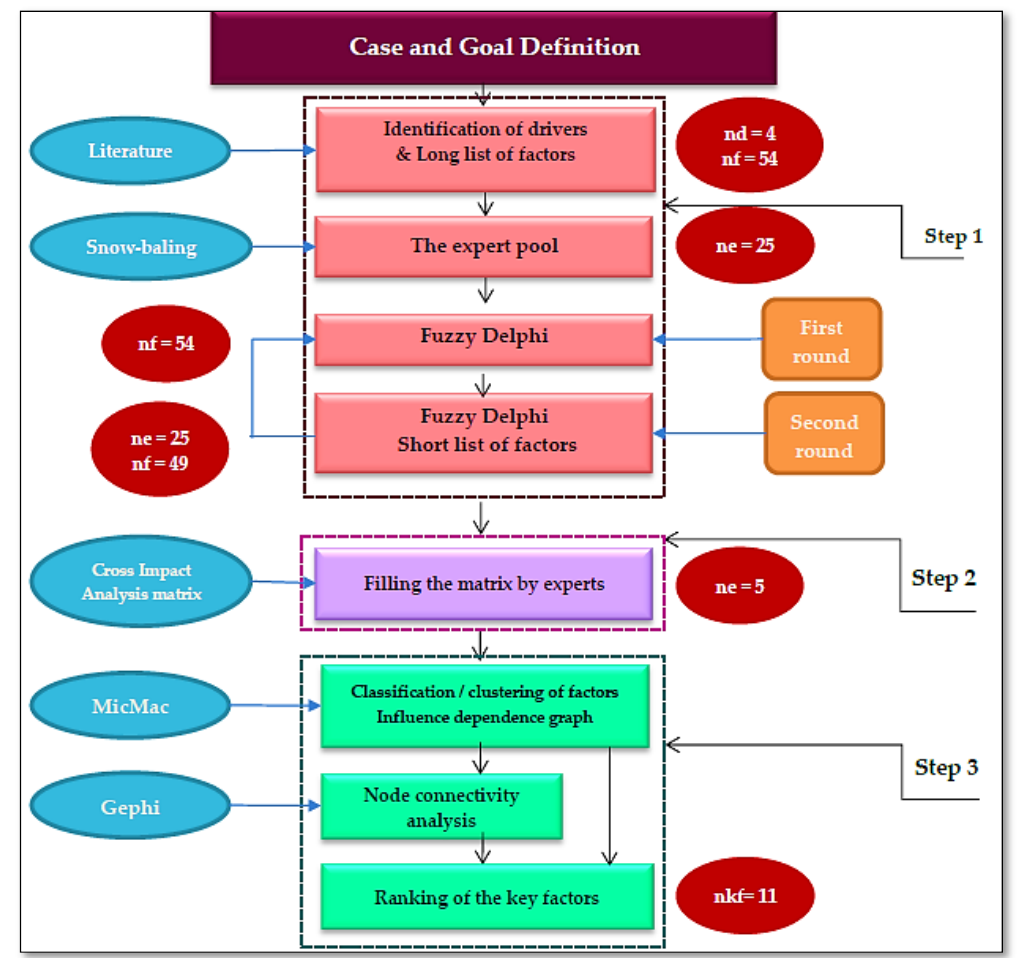
Figure 3. The research process (nd= number of drivers, n e= number of experts, nf= number of factors, nkf= number of key factors).